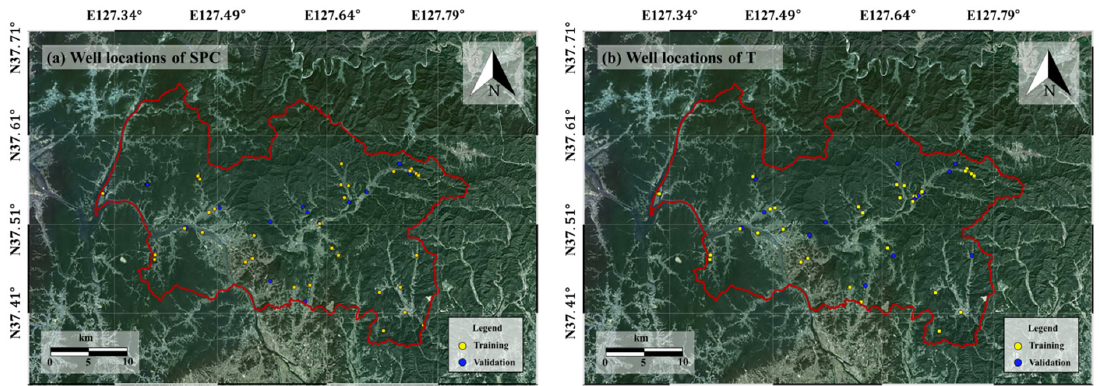
Figure 2. Locations of groundwater wells sampled for: ( a ) SPC and ( b ) T data.